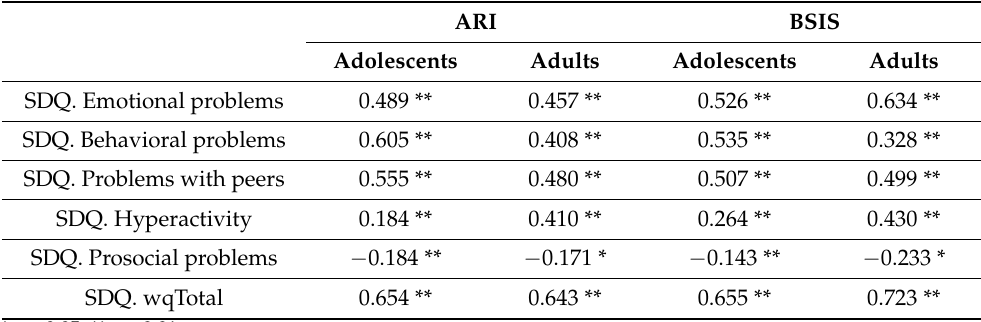
Table 4. Pearson’s correlation coefficients between the Italian version of the ARI and BSIS scales and the SDQ-Ita